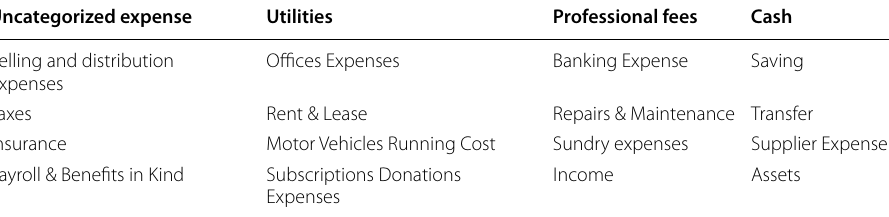
Table 2 List of master categories (i.e. outputs of transaction categorization) Uncategorized